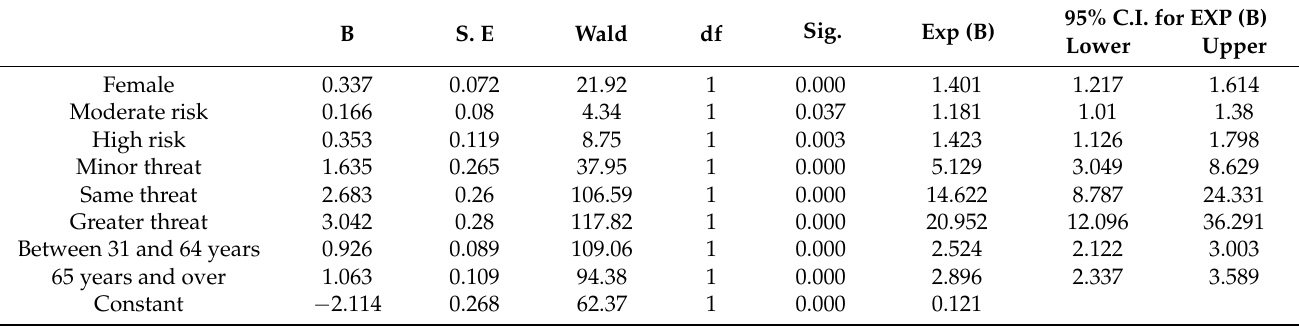
Table 4. Variables in the regression analysis